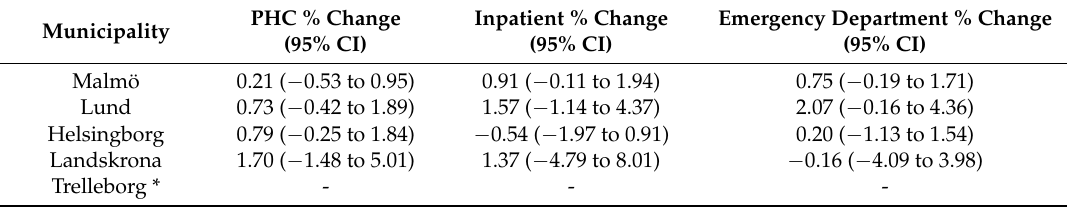
Table 4. Percent change in the number of visits to PHC clinics, inpatient admissions, and emergency department visits with 95% CIs associated with a 10 µ g/m 3 increase in O 3 lag 0–2 in five municipalities during 2005–2010 in multi-pollutant models.